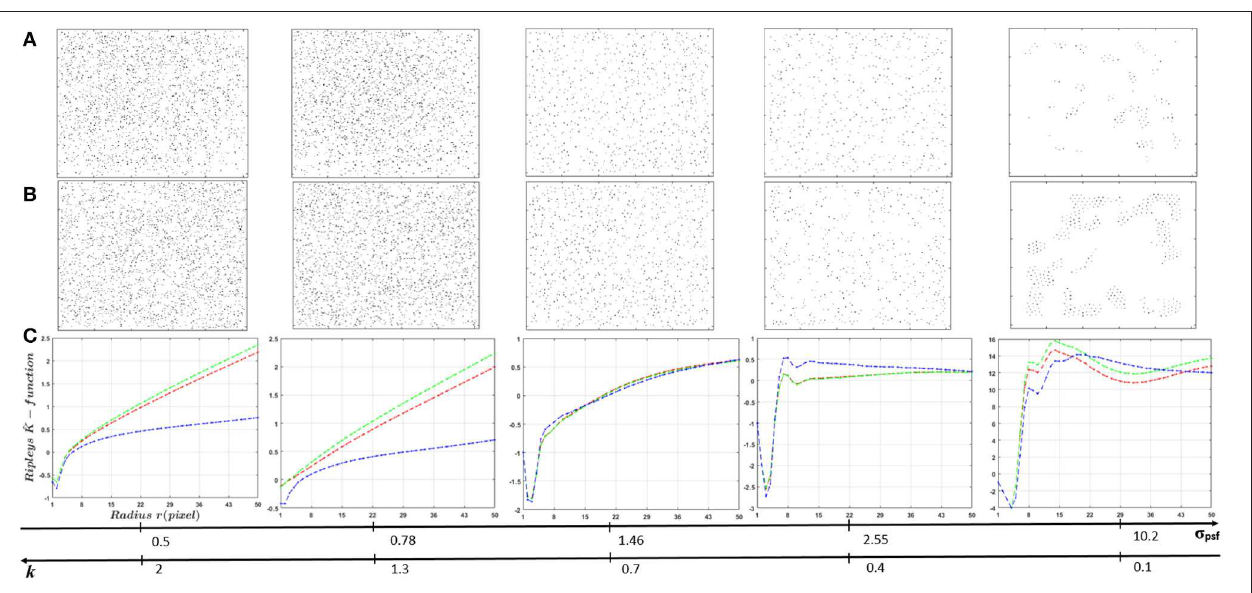
FIGURE 9 | Influence of PSF size (ratio k ) on Ripley’s K-functions ˆ K ( r , n ) of localized markers using UNLOC. (A) Visualization of localized markers in random distribution case. (B) Visualization of localized markers in clustered distribution case. (C) ˆ K ( r , n ) curves. Spatial organization of fluorescent markers changes according to the PSF size. Globally, for small PSF sizes (super-resolution images), markers organizations shows a similar organization as the raw data ( Figure 6 ). Switching to sub-resolution images (large PSF size), spatial organization of detected markers changes due to miss detection caused by UNLOC sensitivity